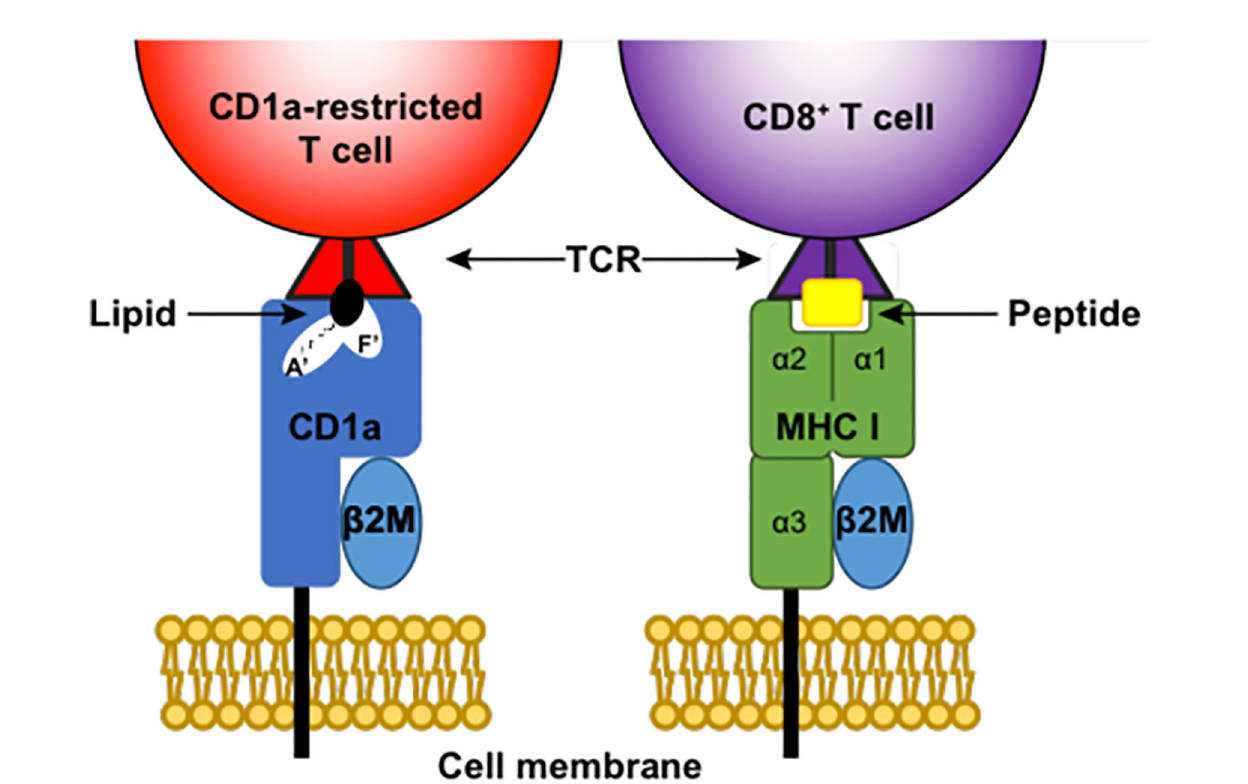
FIGURE 1 | Antigen presentation by CD1a and MHC I. CD1a and MHC (Major histocompatibility complex) I are both membrane-bound complexes that can present antigen to T cells via the T cell receptor (TCR). Both complexes associate with beta2 microglobulin ( b 2M). MHC I presents peptide antigen to CD8+ T cells, while CD1a complexes can house lipids in both the A ’ pocket and F ’ pocket of their large hydrophobic grove and present these lipids to CD1a-restricted T